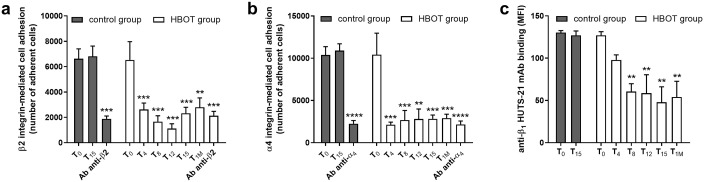
HBOT reduces significantly integrin-mediated neutrophil adhesion to fibrinogen (Fg) or fibronectin (FN).Integrin-mediated adhesion was decreased in neutrophils obtained from patients belonging to HBOT group; no changes were observed in control group patients. The effects of HBOT on neutrophil adhesion mediated by β2 (panel a) or α4β1 (panel b) integrins were evaluated by adhesion assay to Fg or FN respectively, as described in method section. Adhesion mediated by β2 or α4β1 integrin is significantly prevented in neutrophils treated with a monoclonal antibody anti-β2 or anti-α4, respectively. HBOT exposure significantly reduced anti-β1 HUTS-21 mAb binding to neutrophils, namely changing α4β1 integrin conformation (panel c). Mean fluorescence intensity (MFI) due to the anti-β1 integrin mAb PE conjugated HUTS-21 binding in the presence of fibronectin (10 μg/mL) was measured. Non-specific binding of an isotype control PE conjugated mAb added to neutrophils produced an MFI of 12 ± 3 that was subtracted from all samples. Data are expressed as mean ± standard deviation of individual samples, carried out in triplicate at each time point (control group: n = 15; HBOT group n = 15). ** p < 0.01; *** p < 0.001; **** p < 0.0001 versus T0, both control and HBOT group.